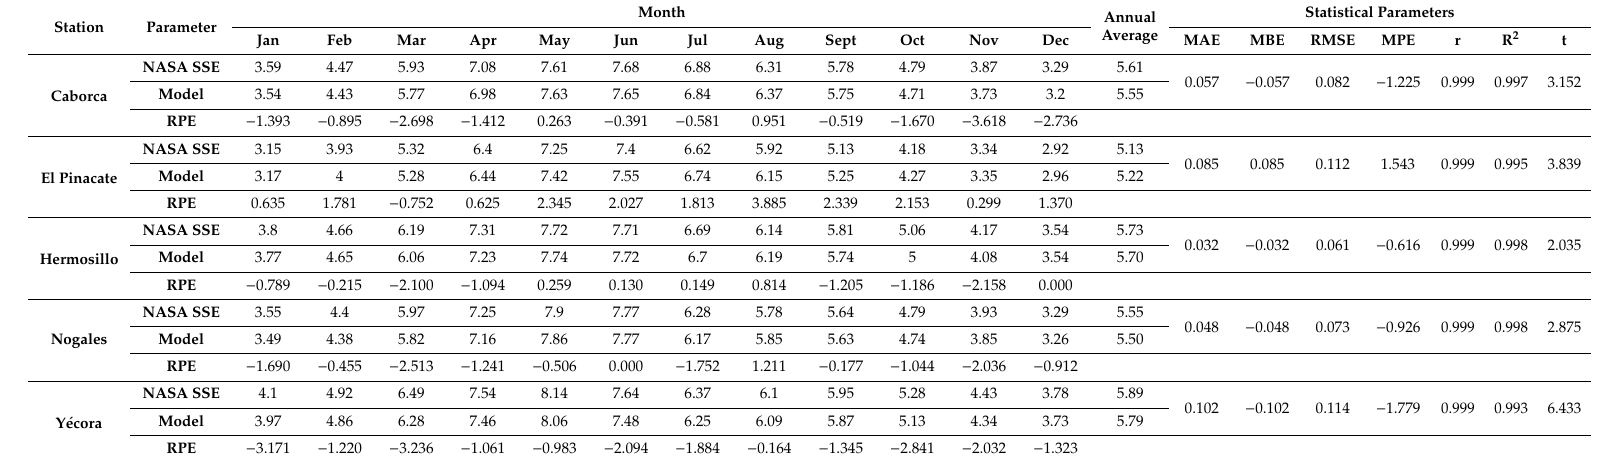
Table 4. Comparison between the NASA SSE database and the model.